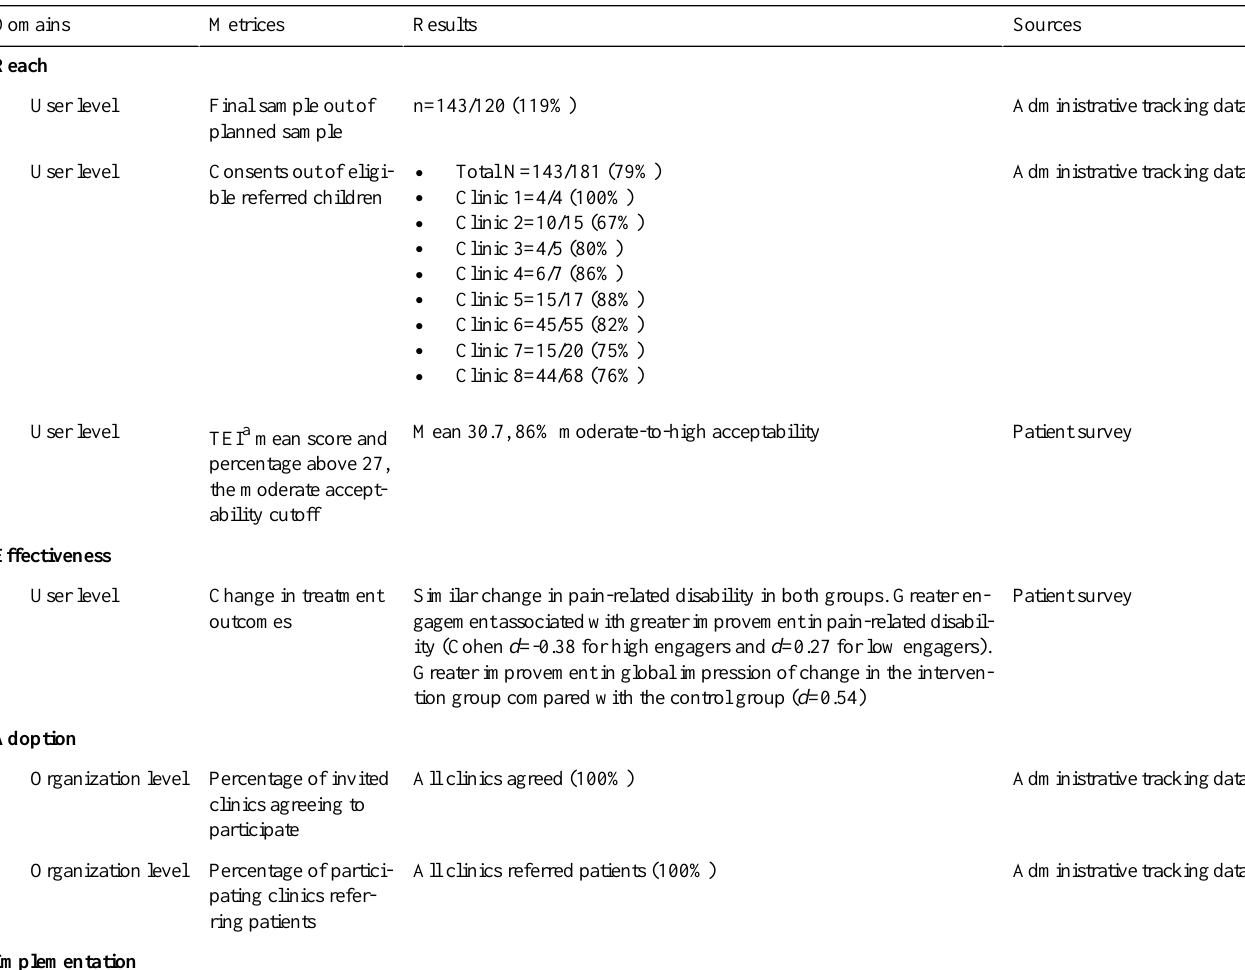
Table 1. Summary of implementation outcomes using the Reach, Effectiveness, Adoption, Implementation, and Maintenance